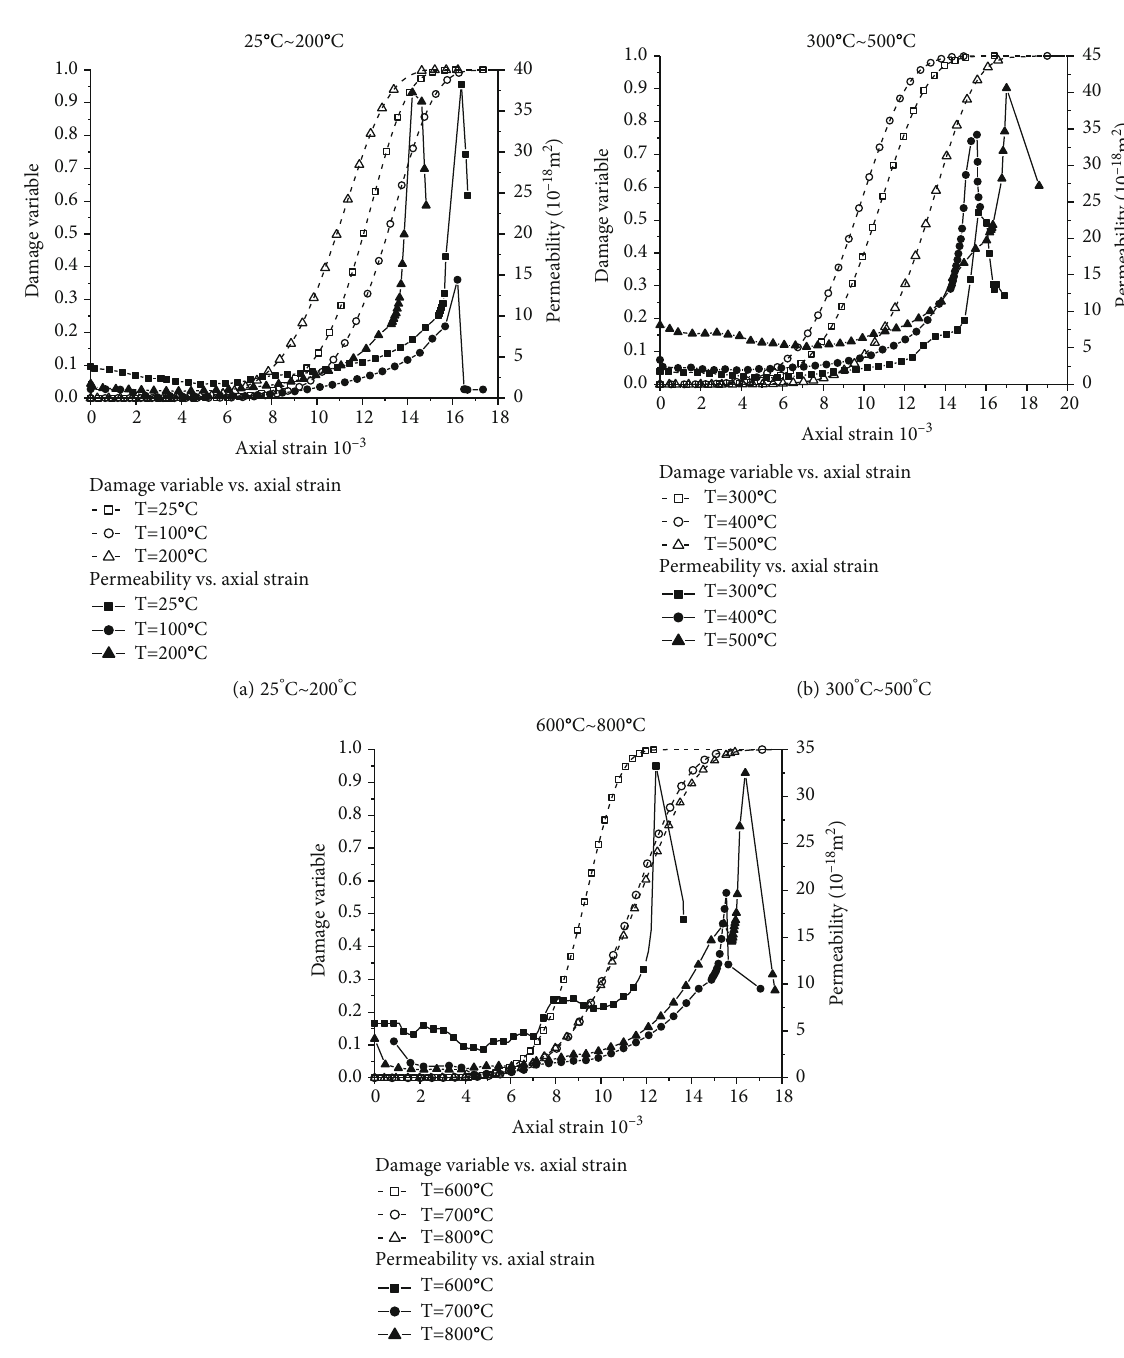
Figure 14: Curves of the permeability and damage variable vs. axial strain of the heat-treated